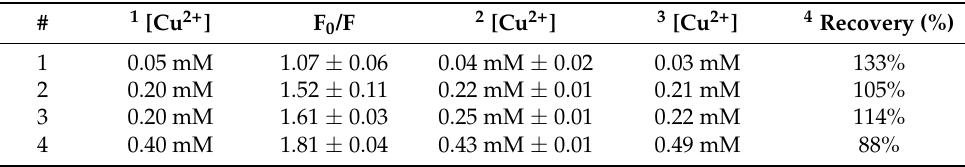
Figure 7. Calibration of Cu 2+ in human urine (sample 3, red dots and fitting) and its quantification in the four urine samples, indicated by the different colors (1—green, 2—violet, 3—black, and 4—blue). The fluorescent signal is reported as F 0 /F at λ em = 450 nm ( λ ex = 350 nm) versus the Cu 2+ concentration, where F 0 and F represent the fluorescence intensity of the SEDF before and after the copper addition, respectively. The error bars represent the standard deviation (n = 4). The analytical parameters of the calibration are reported in Table S2 and were obtained using the piecewise linear fitting implemented in the OriginPro software, version 2022. OriginLab Corporation, Northampton, MA, USA. Table 1. Cu 2+ concentrations in the reinforced urine samples (Figure 7).